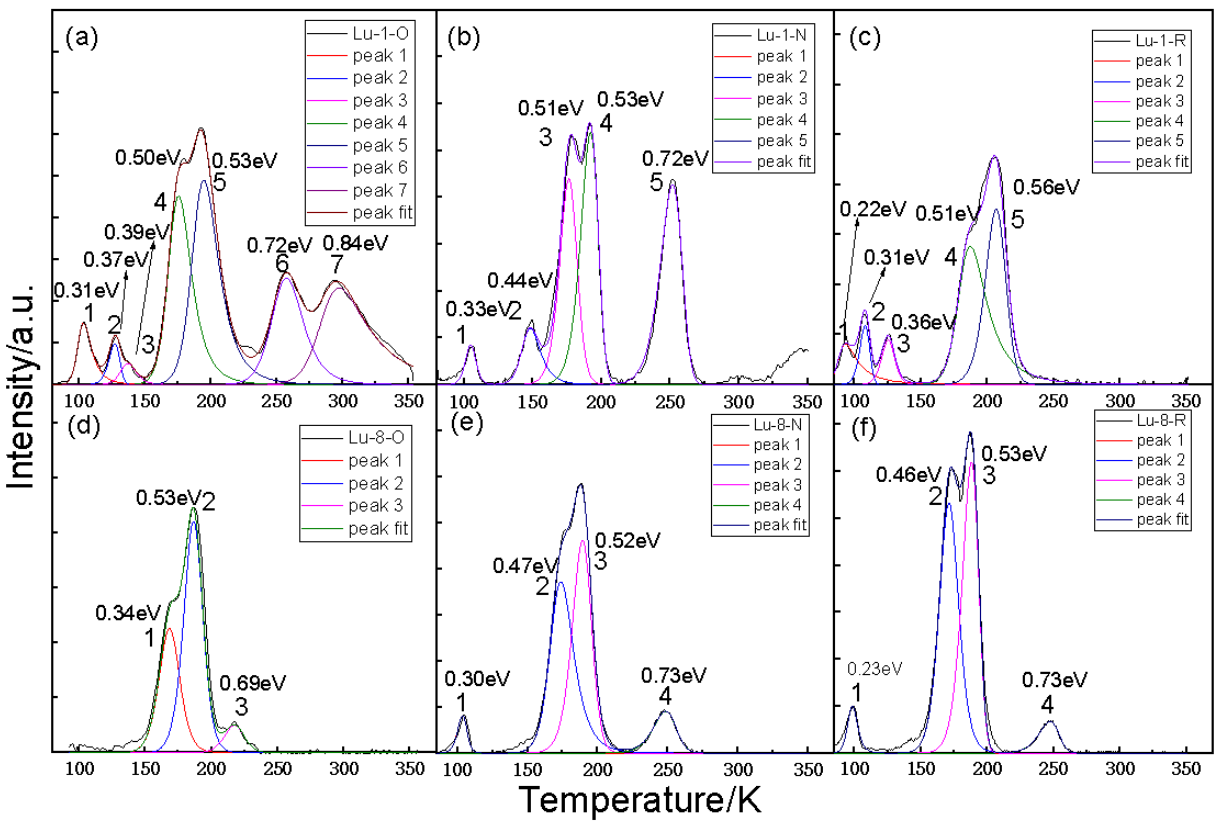
Figure 8. ( a – c ) TSL curves and their fitted curves of 1%Lu 2 O 3 :Eu single crystals. ( d – f ) TSL curves and their fitted curves of 8%Lu 2 O 3 :Eu single crystals. Table 2. The TSL fitted results of Lu 2 O 3 :1%Eu and Lu 2 O 3 :8%Eu single crystals. Lu ‐ 1 ‐ O Lu ‐ 1 ‐ N